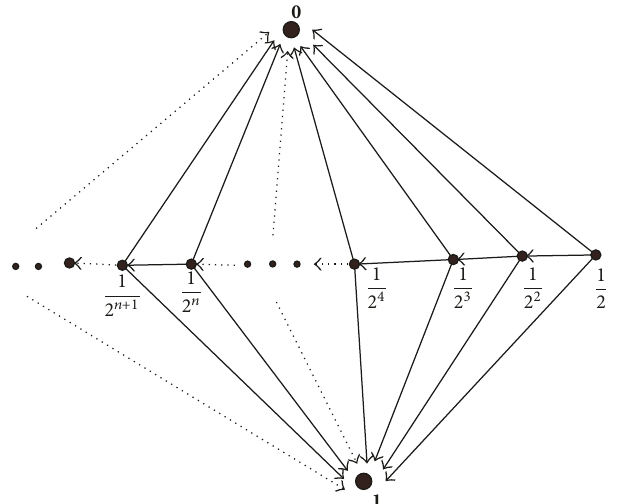
Figure 2: Graph 𝐺 󸀠 (the loops and the isolated vertices are not